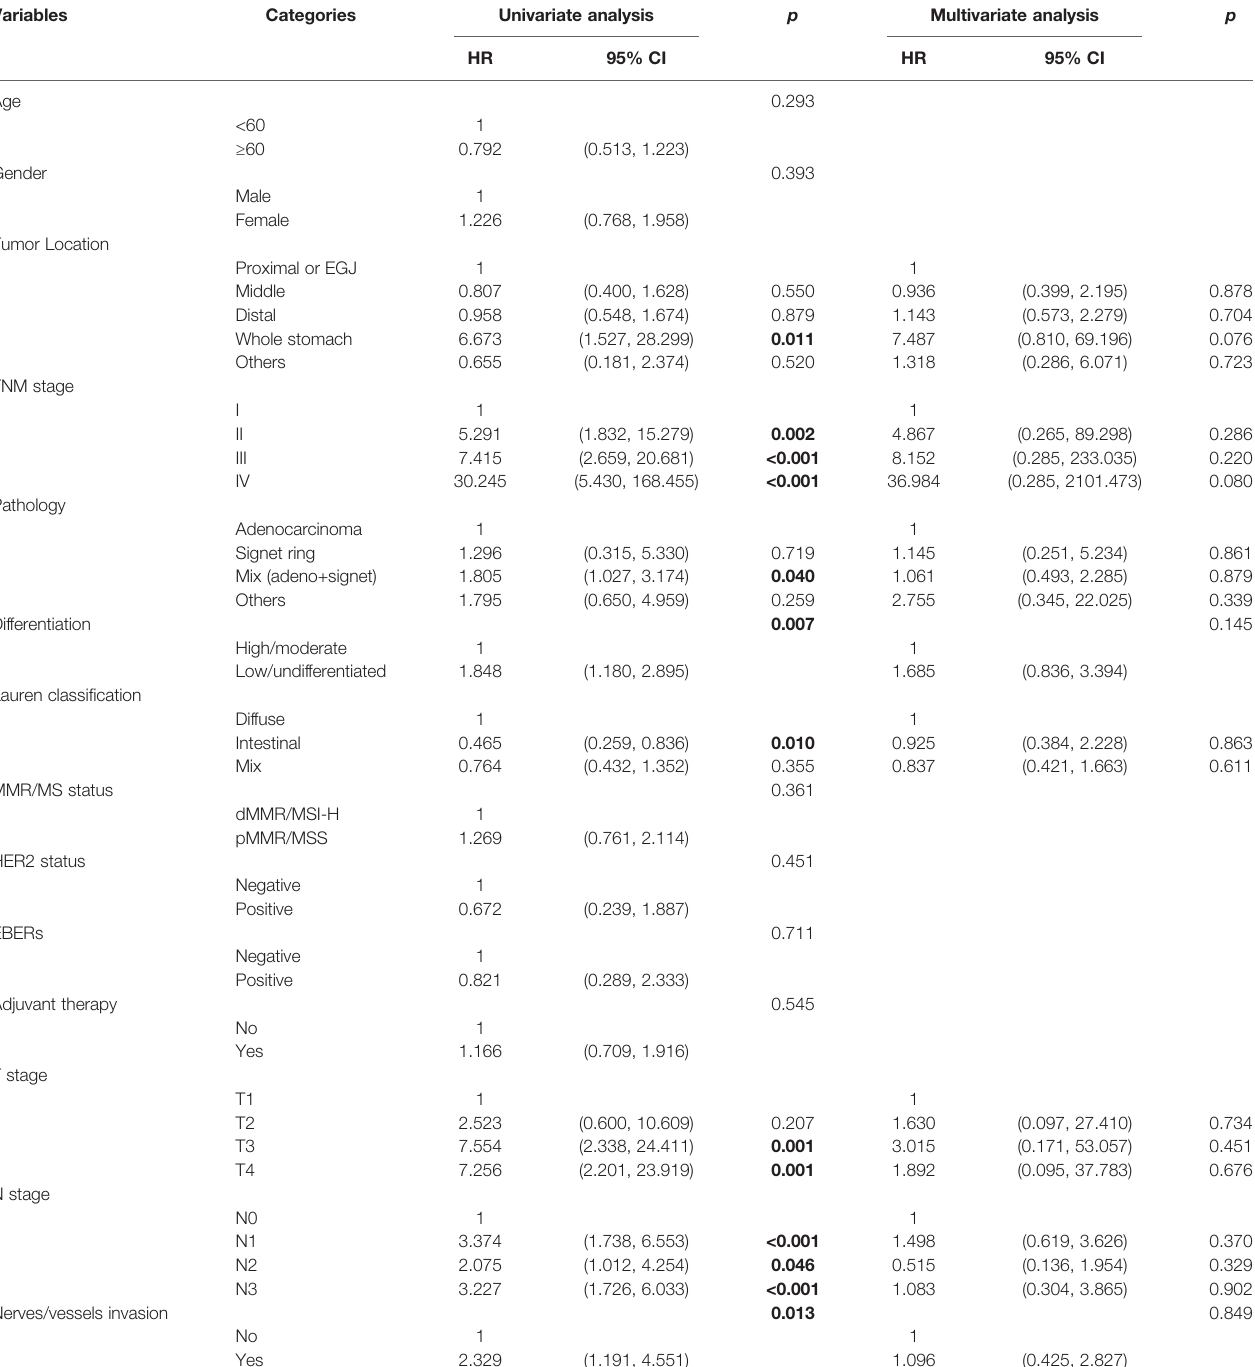
TABLE 4 | Univariable and multivariable Cox proportional hazard models for disease-free